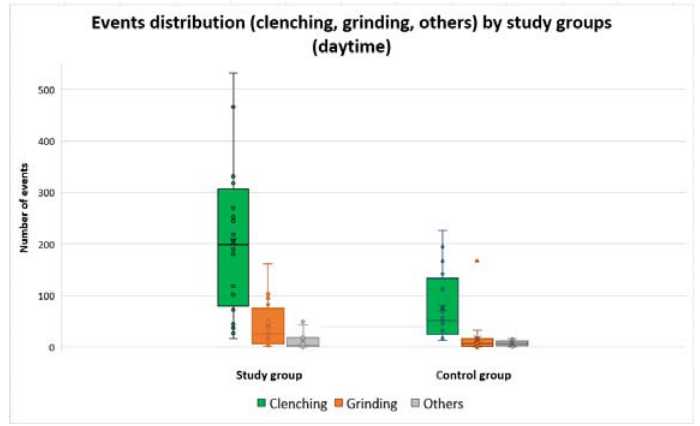
Figure 4. Distribution of clenching, grinding, and other types of events, for the two groups, during daytime.